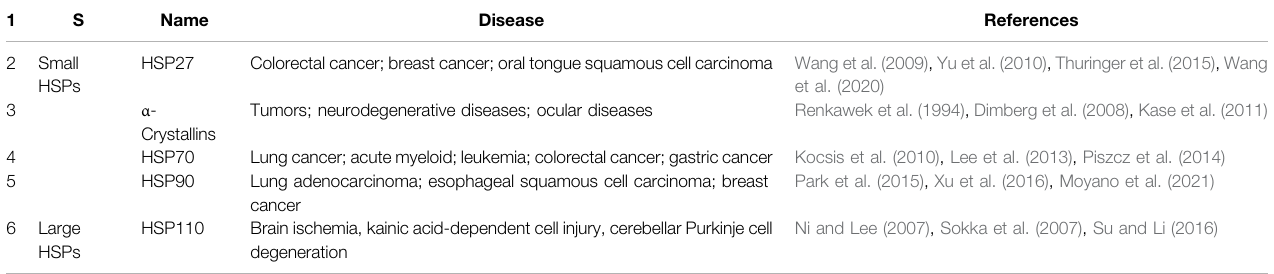
TABLE 1 | Small and large HSPs involved in diseases.